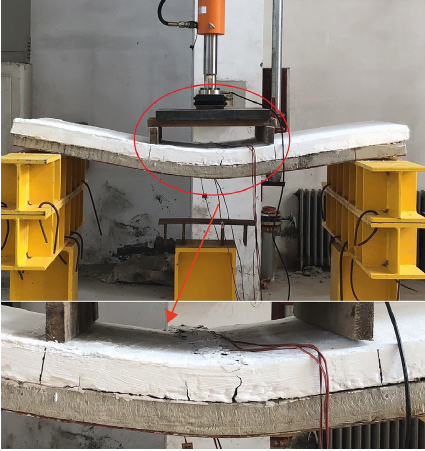
Figure 5: Typical failure mode of the ICSIPs.